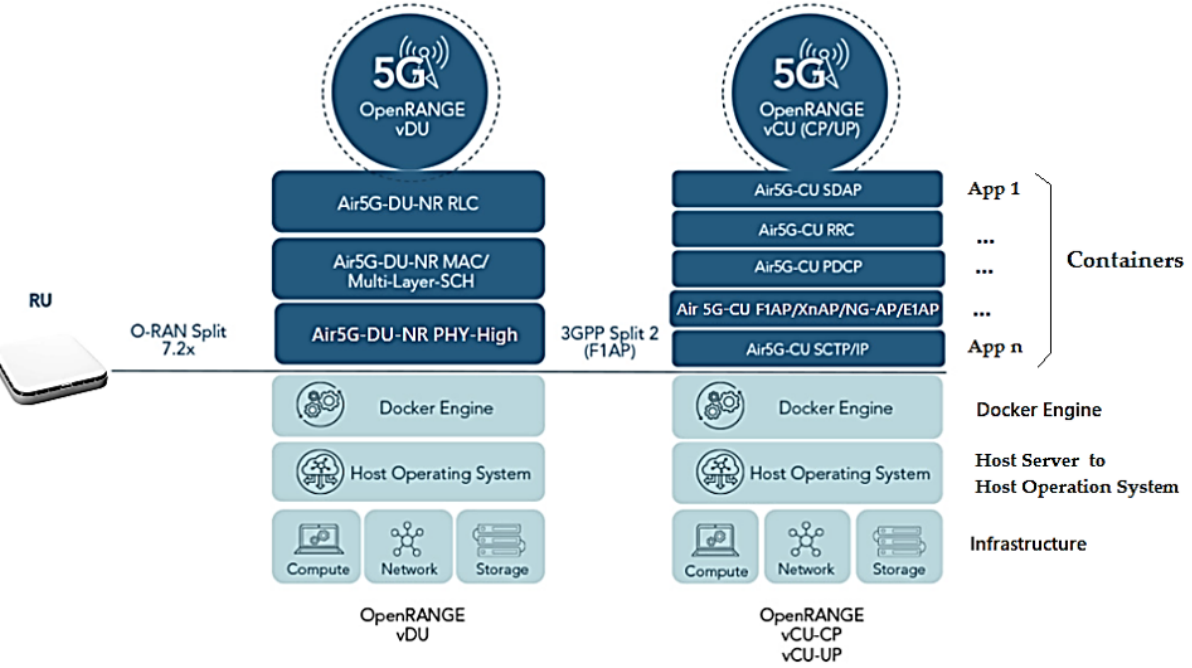
Figure 13. Architecture of Container Network Functions (CNF) with applications running on O- DU/O-CU Servers with OpenRange Software for vDU and vCU. Based on